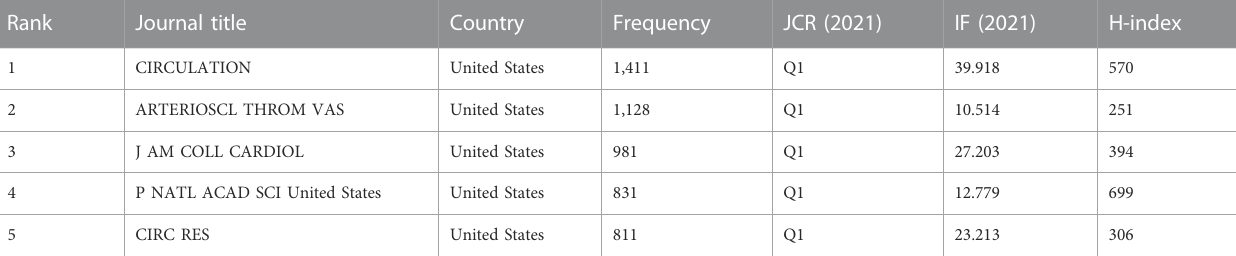
TABLE 4 Top fi ve co-cited journals of molecular imaging research in AS in terms of frequency.